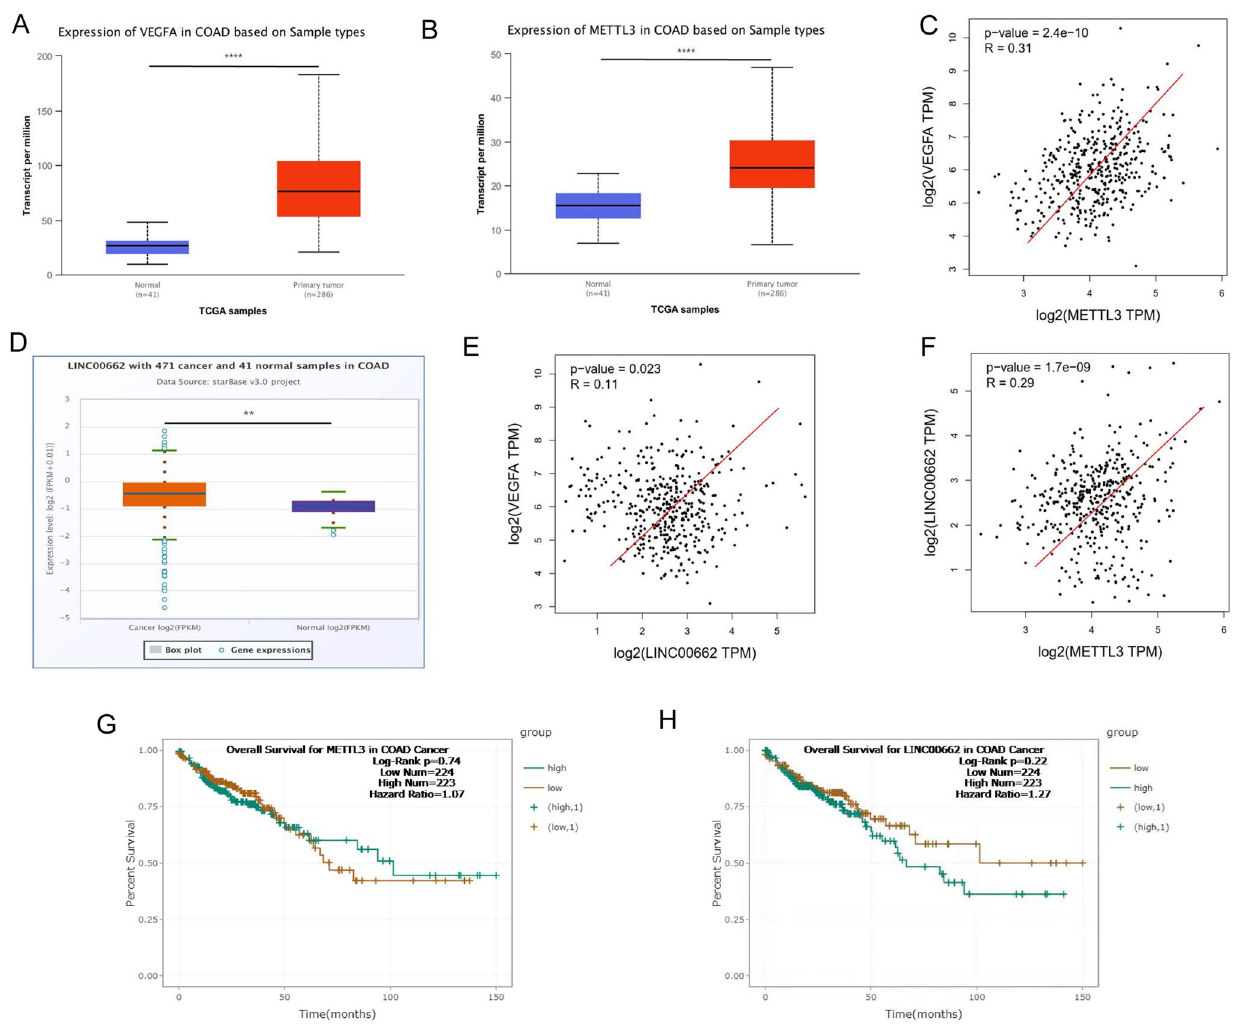
Fig. 1 METTL3 was positively correlated with LINC00662 and VEGFA. A The expression of VEGFA mRNA in TCGA CRC database. B The expres- sion of METTL3 mRNA in TCGA CRC database. C METTL3 mRNA was significantly positively correlated with VEGFA in TCGA CRC database. D LINC00662 mRNA was highly expressed in CRC in TCGA starBase database. E LINC00662 mRNA was significantly positively correlated with VEGFA in TCGA starBase database. F METTL3 mRNA was significantly positively correlated with LINC00662 in TCGA starBase database. G Sur- vival curve analysis for METTL3 in CRC in TCGA CRC starBase database. H Survival curve analysis for LINC00662 in CRC in TCGA CRC starBase